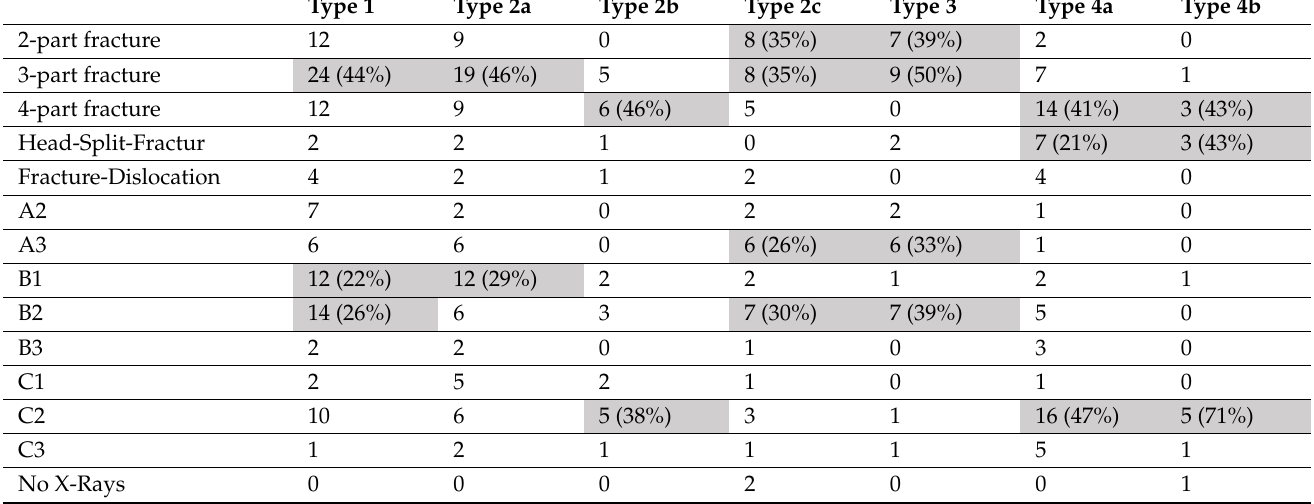
Table 6. Distribution of complication types among the individual fracture types of the Neer classifica- tion and AO classification. The fields with a dark background reflect the dominant fracture group(s) of the respective complication types (with associated percentage